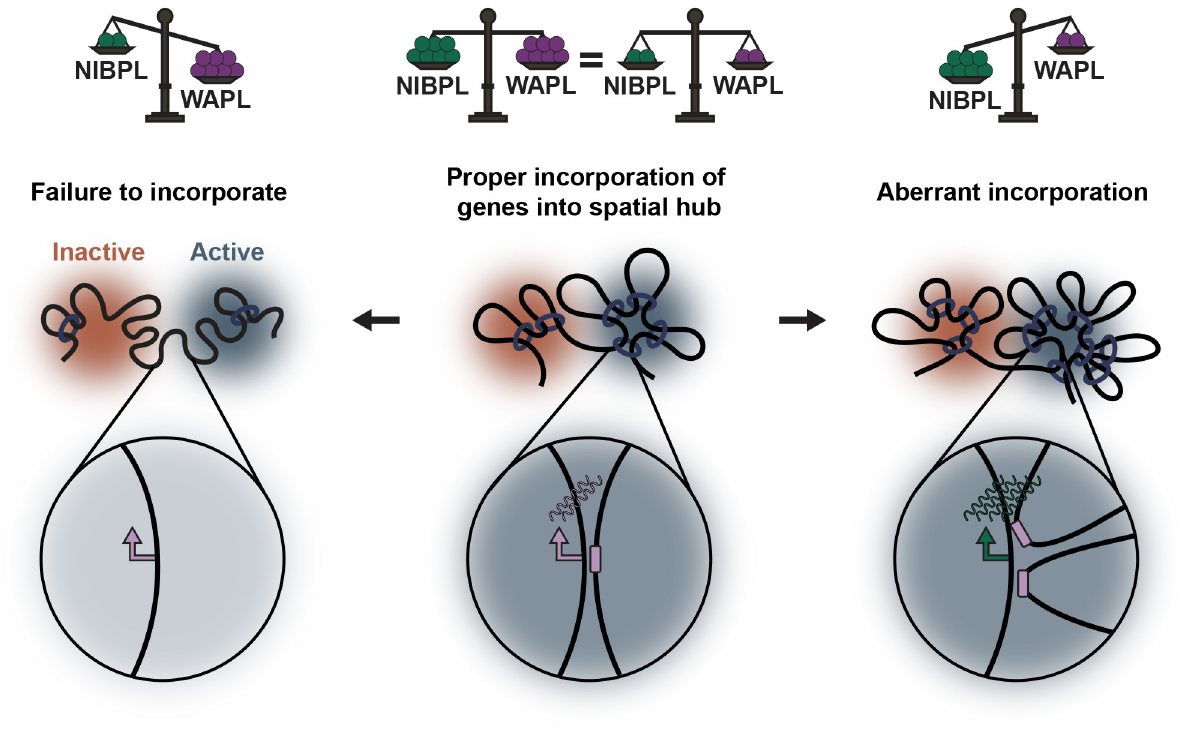
Fig 6. NIPBL and WAPL balance cohesin activity to regulate chromatin organization and gene expression. Cohesin normally promotes the compaction and clustering of chromatin into TADs, which we propose act as regulatory hubs. These hubs can either stimulate (Active, blue) or repress (Inactive, Red) expression of nearby genes in a dynamic fashion. Depletion of NIPBL would limit loop extrusion events and processivity, resulting in less frequent incorporation of distal genes into their target hubs. As depicted, an active gene (purple) could be displaced from its active hub and spatially separated from its target enhancer, leading to its downregulation. In contrast, WAPL depletion would effectively increase loop extrusion events and lead to the ectopic incorporation of distal genes into new hub environments. As depicted, a silent gene (green) could be aberrantly activated when positioned inside an active hub with active enhancers (purple) in close proximity. Co-depletion of NIPBL and WAPL would therefore balance cohesin activity, restore chromatin folding, and correct hub formation to effectively rescue gene expression.